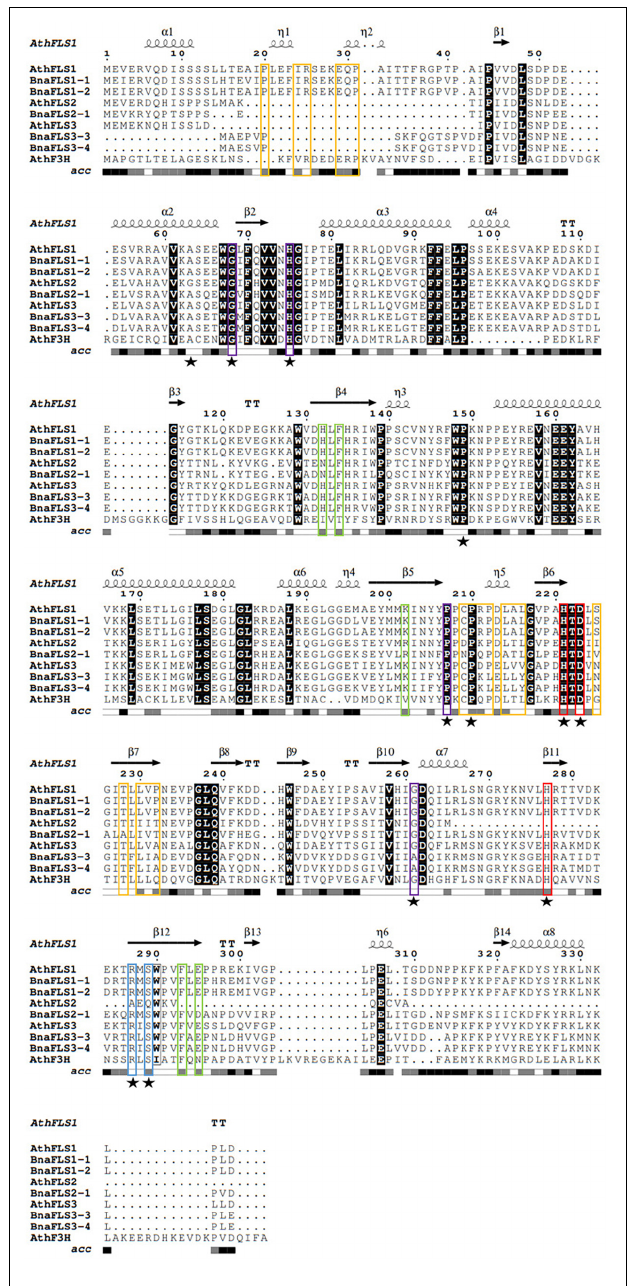
FIGURE 4 | Multiple sequence alignment of BnaFLS candidates relevant for seed flavonol accumulation. Conserved amino acids and motifs important for FLS functionality were labeled as followed: the “PxxxIRxxxEQP,” “CPQ/RPxLAL,” and “SxxTxLVP” motifs are shown in orange, while residues involved in substrate-, ferrous iron-, and 2-oxoglutarate-binding are marked in green, red, and blue, respectively. Residues important for proper folding and/or highly conserved across 2-ODDs are labeled in violet. Residues relevant for F3H activity are marked with a black star. Black background indicates perfect conservation across all sequences. Secondary structure information is derived from an in silico model of AthFLS1 predicted by I-TASSER. acc = relative